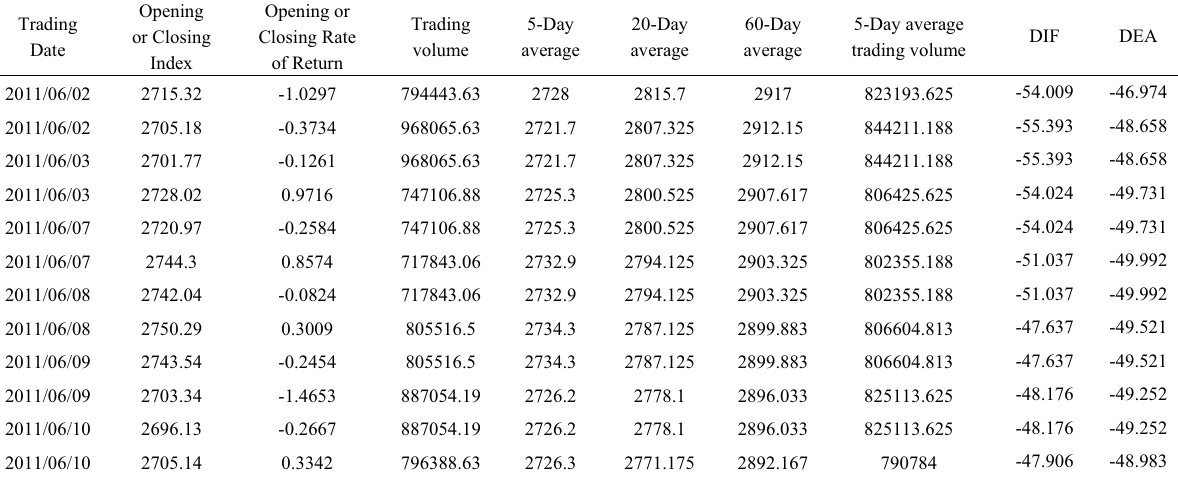
Table 4. Part of the original data